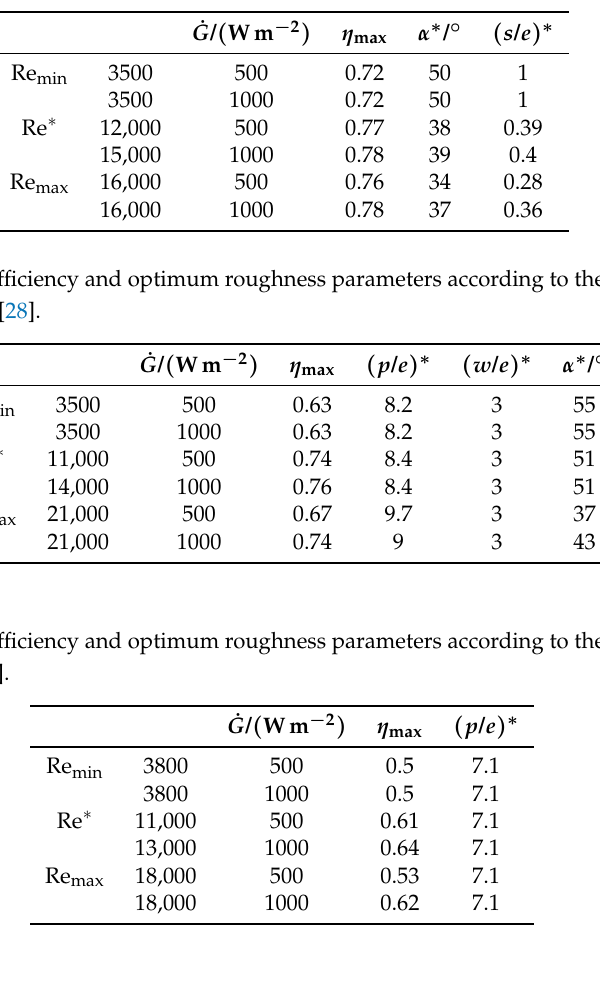
Table 14. Maximum efficiency and optimum roughness parameters according to the model developed by Chamoli et al. [51].